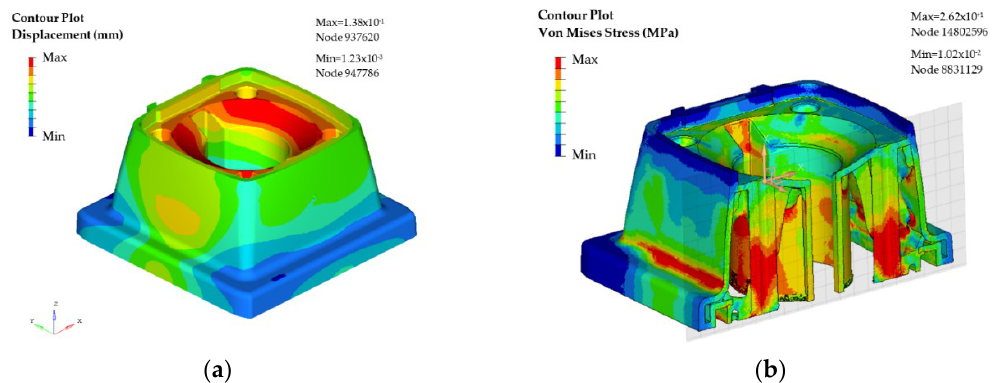
Figure 12. CAE of the case study part (support): ( a ) Displacement results in the optimized design, and ( b ) Von Mises stress result in the optimized design.